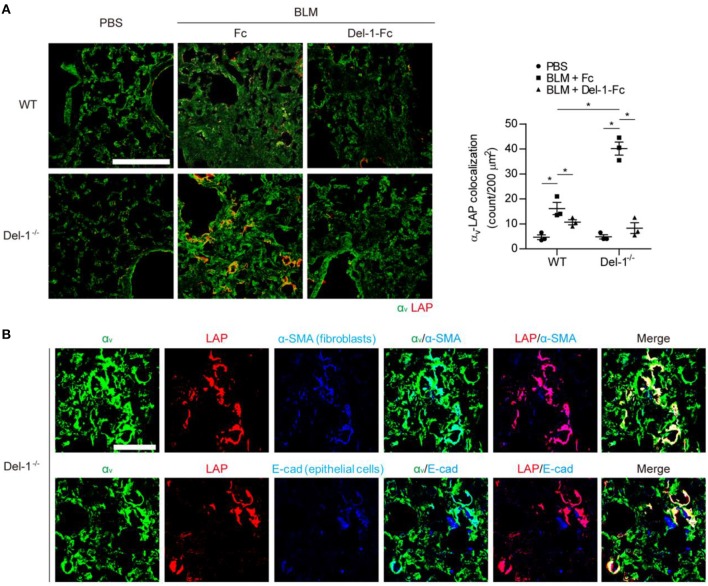
Endogenous and exogenous Del-1 inhibit the interaction between αv integrin and LAP in vivo. (A) Representative lung sections showing colocalization of αv integrin with LAP in WT and Del-1−/− mice with BLM-induced PF supplemented with control Fc or Del-1-Fc (intravenous injection; 50 μg/dose Fc or Del-1-Fc on Days 5, 9, and 13 post-BLM instillation; n = 3 mice/group). Lung samples were collected at 21 dpa. Green, αv integrin; red, LAP. Scale bar = 200 μm. Quantification of the colocalization is shown in the right panel. In each section, the number of double-positive cells per 200 μm2 was counted. Data are expressed as the mean ± SEM. *p < 0.05; Mann-Whitney U-test. (B) Representative images showing colocalization of αv integrin with LAP in fibroblasts or epithelial cells in lungs from Del-1−/− mice with BLM-induced PF (n = 3 mice/group). Green, αv integrin; red, LAP; blue, activated fibroblasts (α-SMA); blue, epithelial cells (E-cadherin). Scale bar = 50 μm.